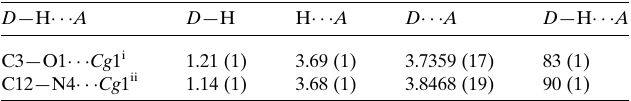
Table 1 (cid:2) (Triazolyl) interaction geometry (A˚ , (cid:2) ). Cg 1 is the centroid of the N1–N3/C1/C2 ring.